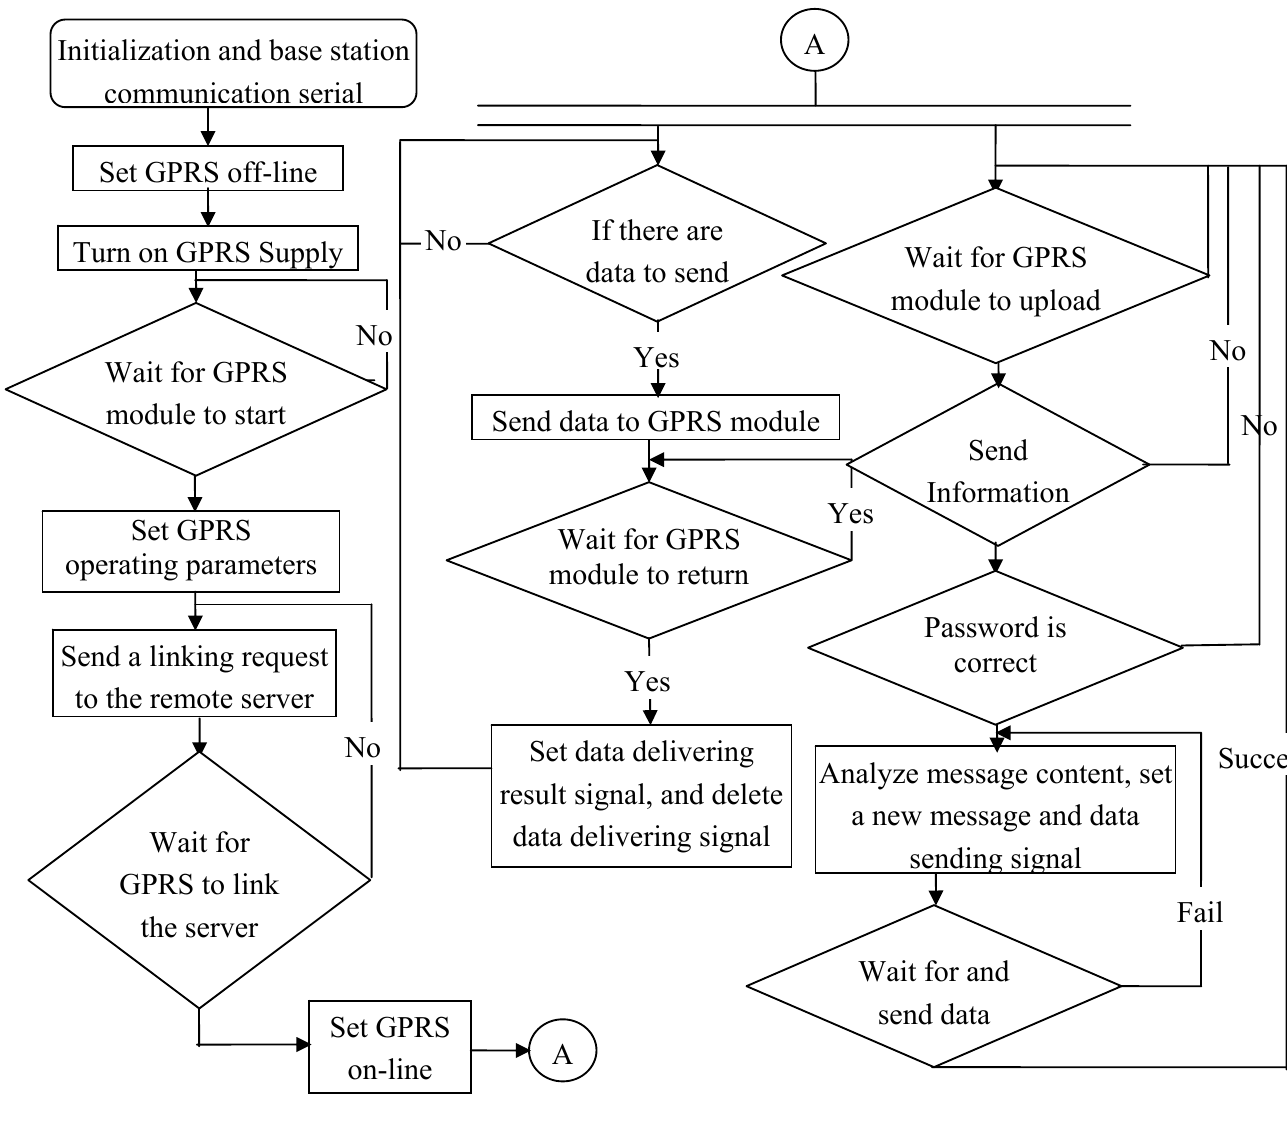
Figure 11. The base station and the GPRS communication